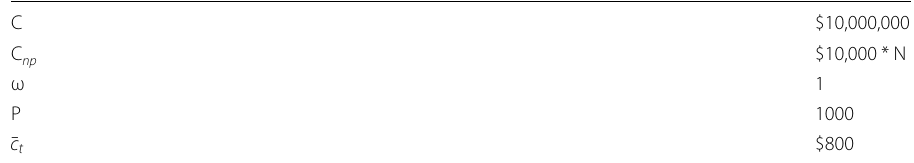
Table 3 Initial variable assumptions for all scenarios